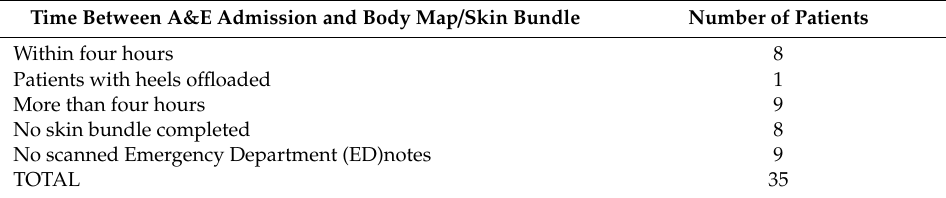
Table 3. Time between A&E admission and body map / skin bundle. (35 patients * 2 patients had no A&E